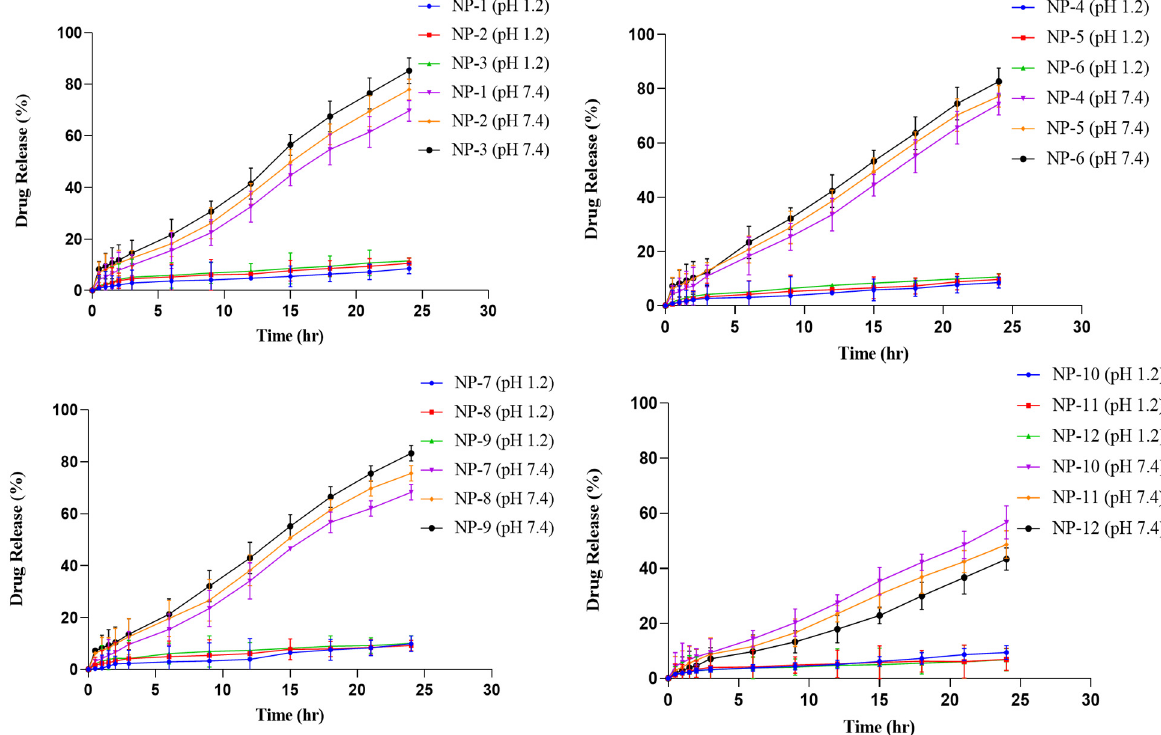
Figure 12. Cytarabine release studies in acidic (pH 1.2) and basic medium (pH 7.4) . Table 2. Cytarabine release